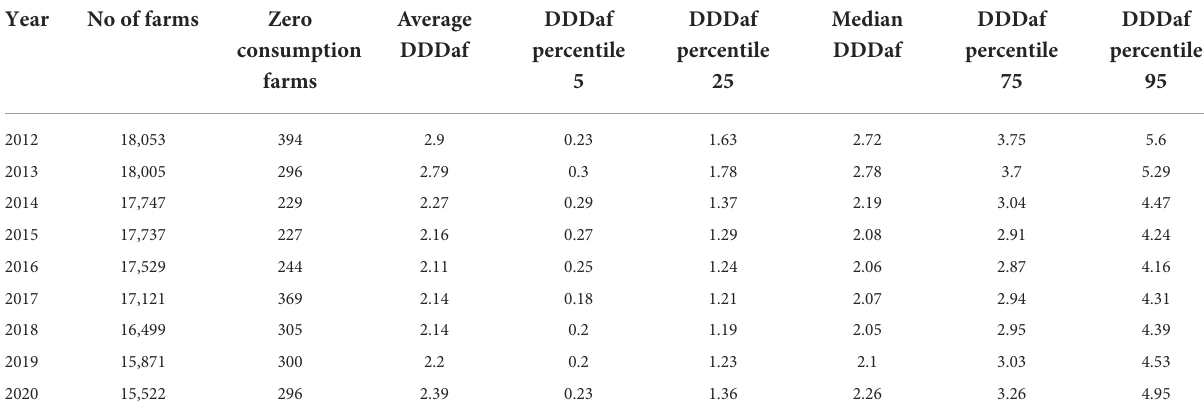
TABLE 3 Total number of farms, average farm’s antimicrobial consumption, percentage of zero consumption farms, and percentiles 5, 25, 50, 75 and 95 from 2012 to 2020, in DDDA F